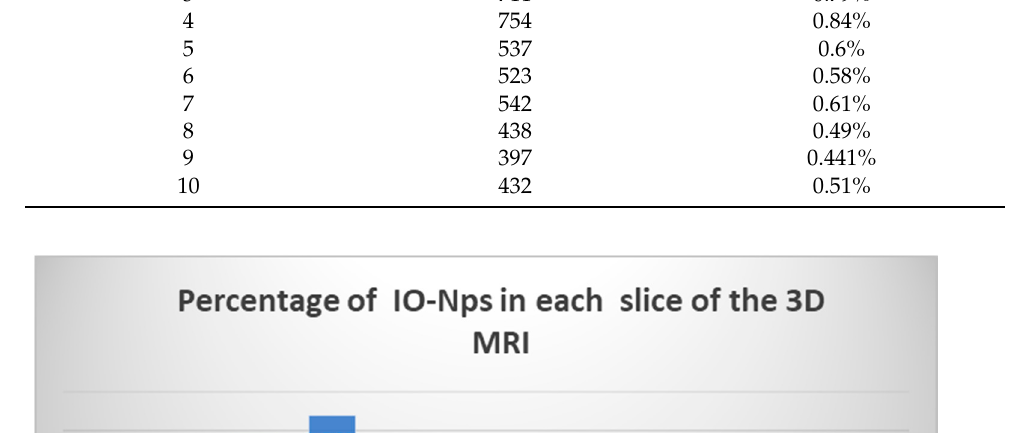
mouse calf and the extracted IO-NPs represented by white pixels are counted in each slice.